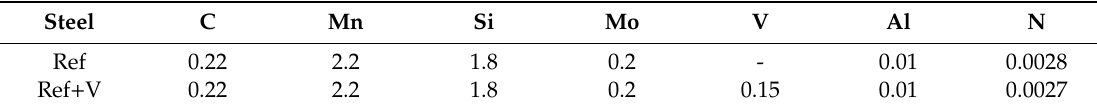
Table 1. Chemical compositions of the studied steels, wt.